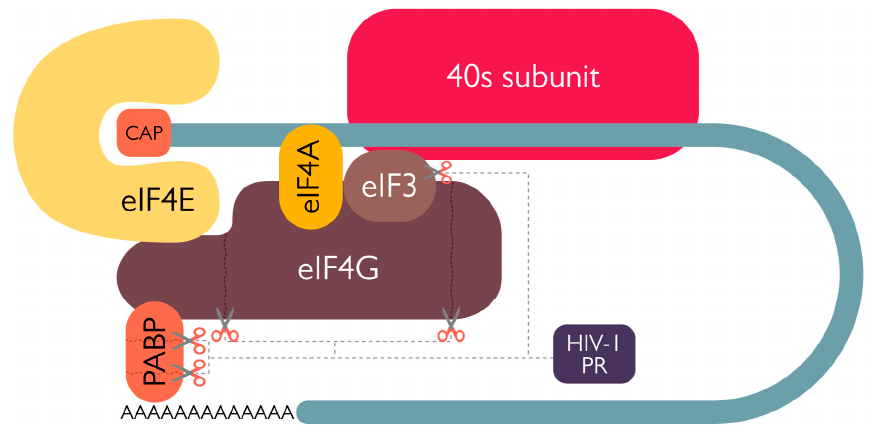
Figure 6. Schematic representation of eukaryotic 43S pre-initiation complex with HIV-1 PR cleavage